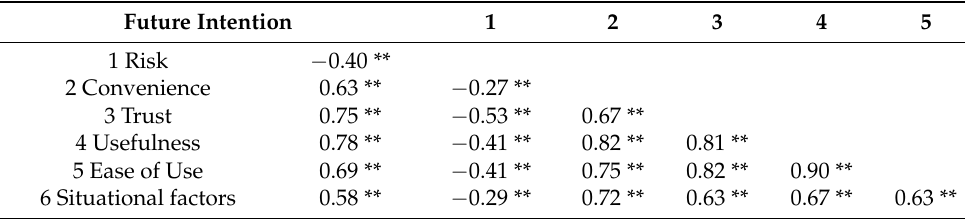
Table 3. Correlation